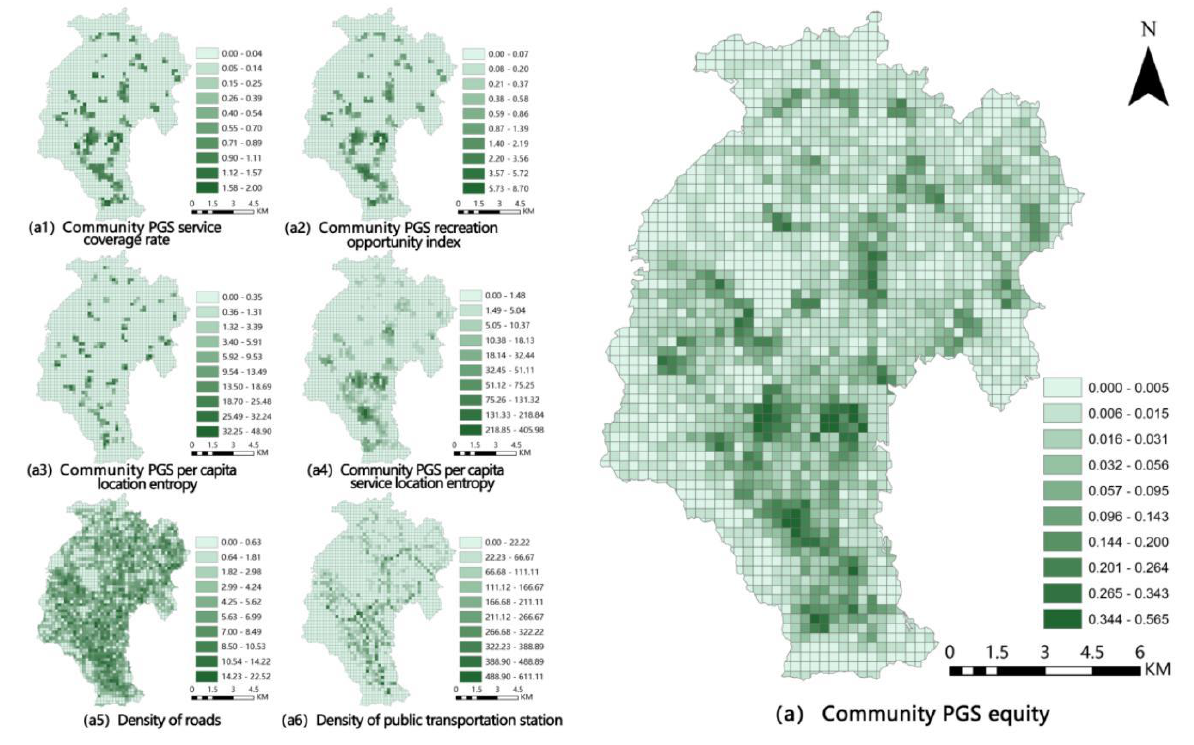
Figure 4. Equity indexes of community PGS.